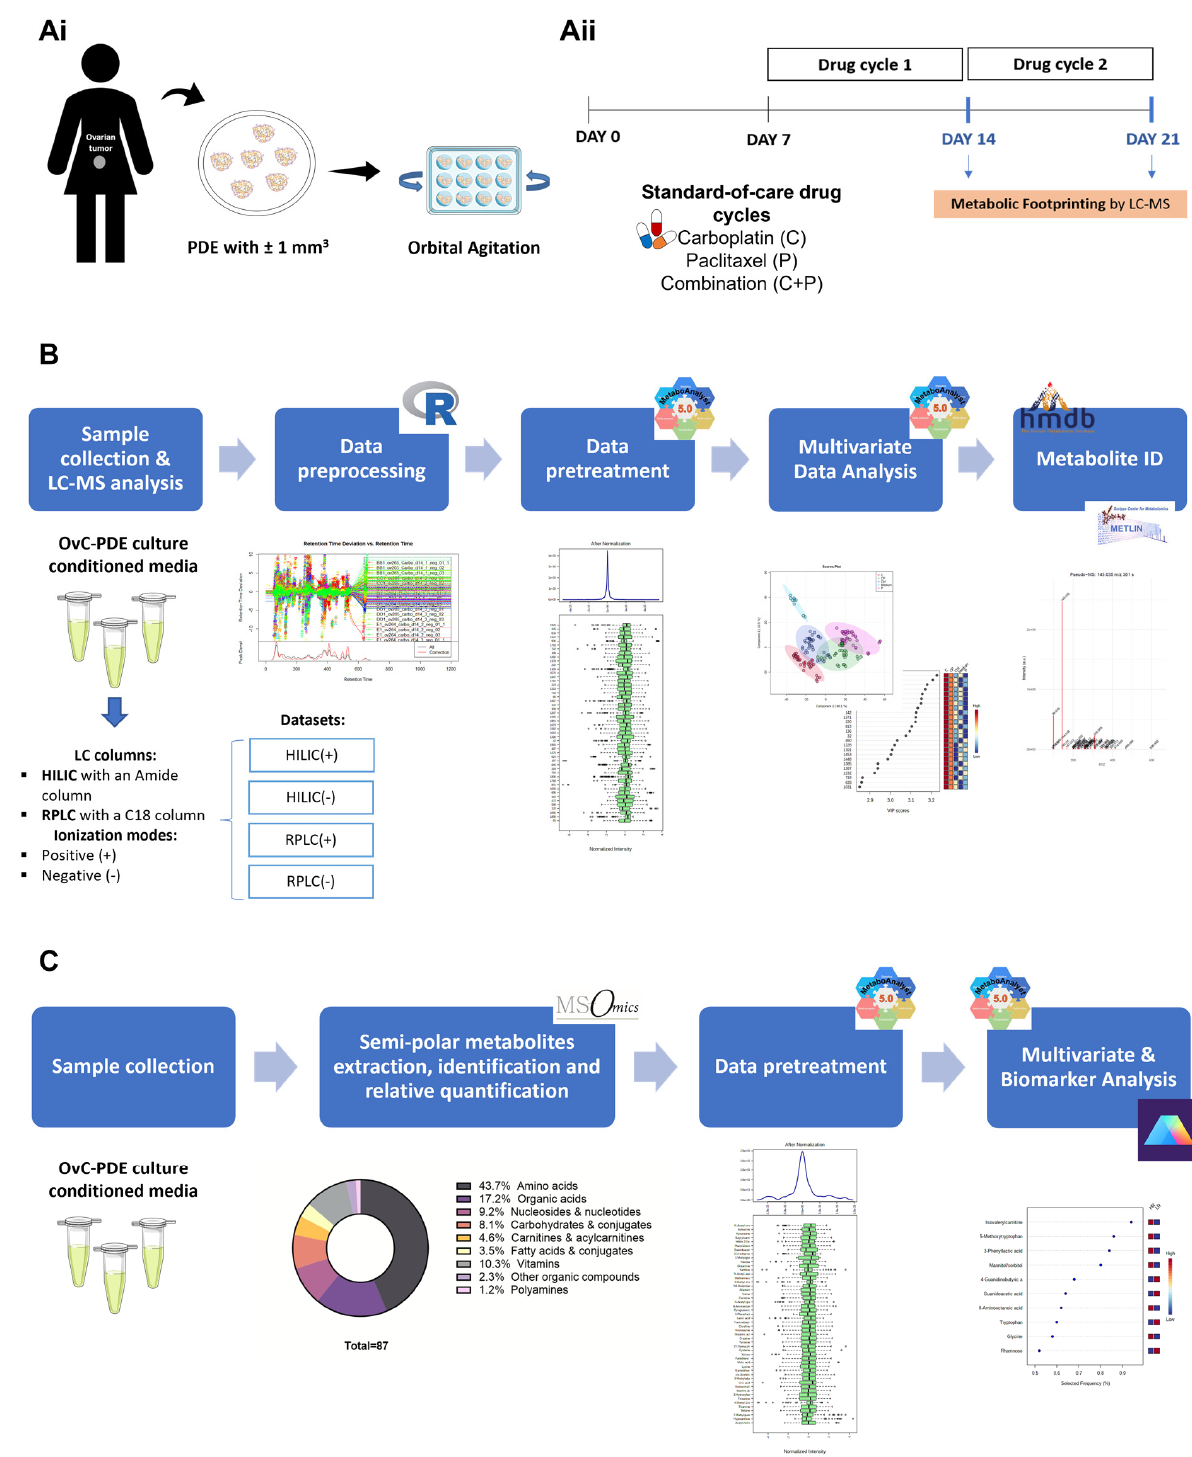
Figure 2. Workflow of the experimental strategy for ( Ai ) patient-derived ex vivo (PDE) culture establishment, ( Aii ) drug assays, approach, and readouts, ( B ) untargeted metabolomic analysis and ( C ) semi-targeted metabolomics. (OvC: ovarian carcinoma; PDE: patient-derived explant; LC-MS: liquid chromatography-mass spectrometry; HILIC: hydrophilic interaction liquid chromatography; RPLC: reversed phase liquid chromatography; ID: identification) .